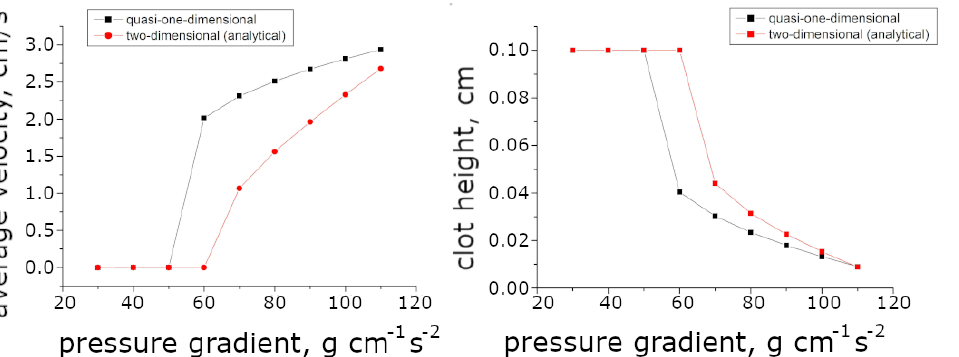
Figure 7. The average velocity above the clot ( left ) and the final clot size ( right ) for different values of pressure difference between the inlet and outlet of the flow in the quasi-one-dimensional calculations (black) and analytical solution (red) in the network of three vessels (Figure